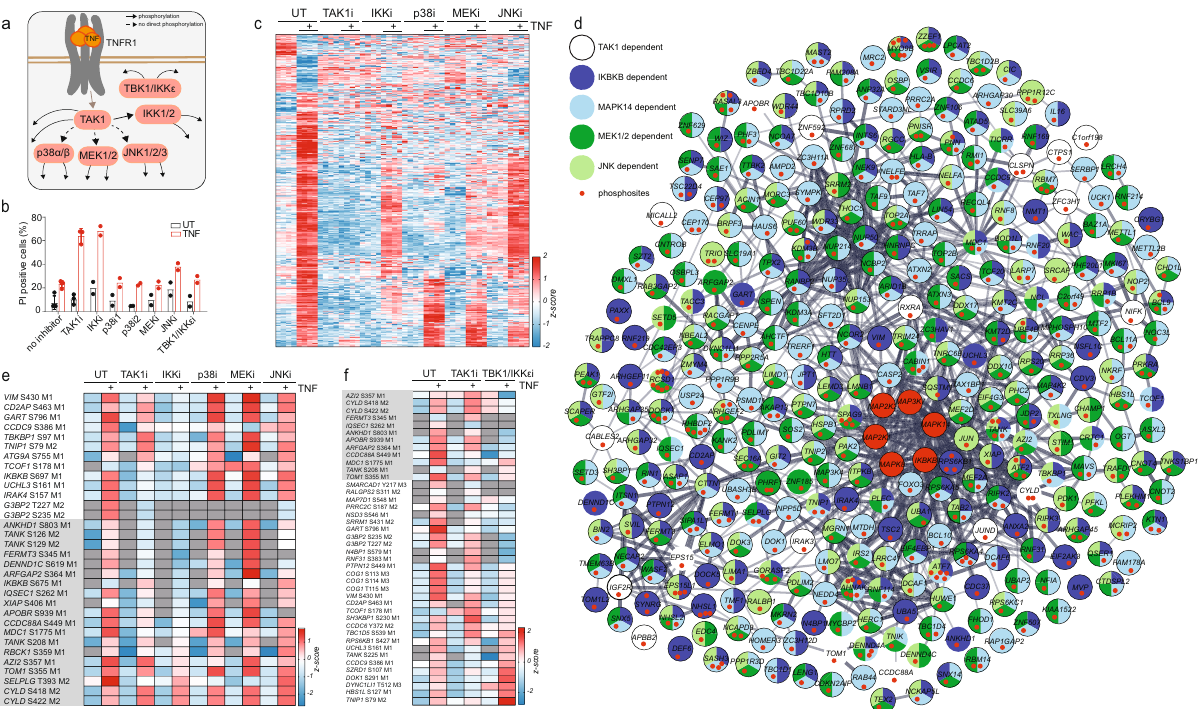
Fig. 2 Kinase inhibition unravels kinase-substrate relations upon TNF stimulation. a TNF-signaling scheme highlighting kinase hubs that we inhibited